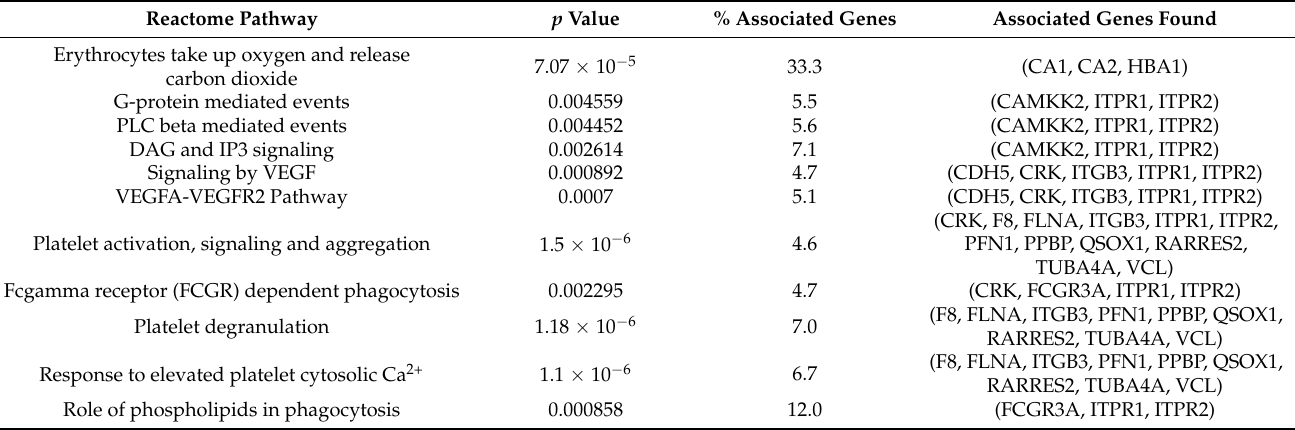
Table 4. Pathway enrichments for the sensitive group. Significance was defined with a two-sided hypergeometric test in ClueGo. P value corresponds to the Benjamini–Hochberg correction.